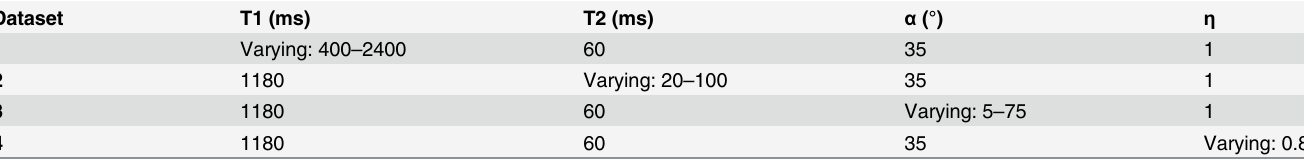
Table 1. T1, T2, α and η parameters used to generate the four different datasets using Bloch equations simulation. Dataset